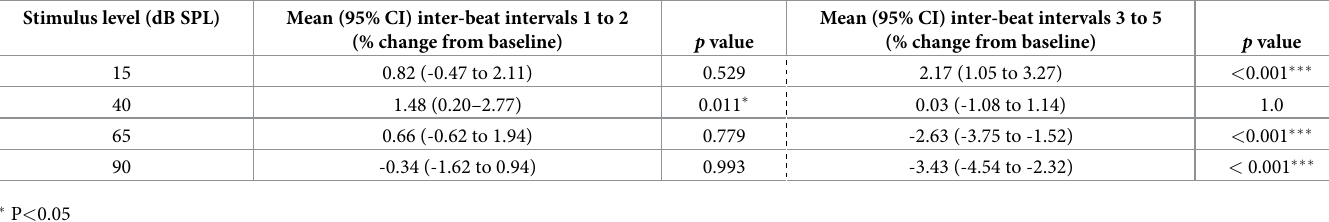
Table 1. Mean (95% confidence interval) percentage change in inter-beat intervals from baseline, across